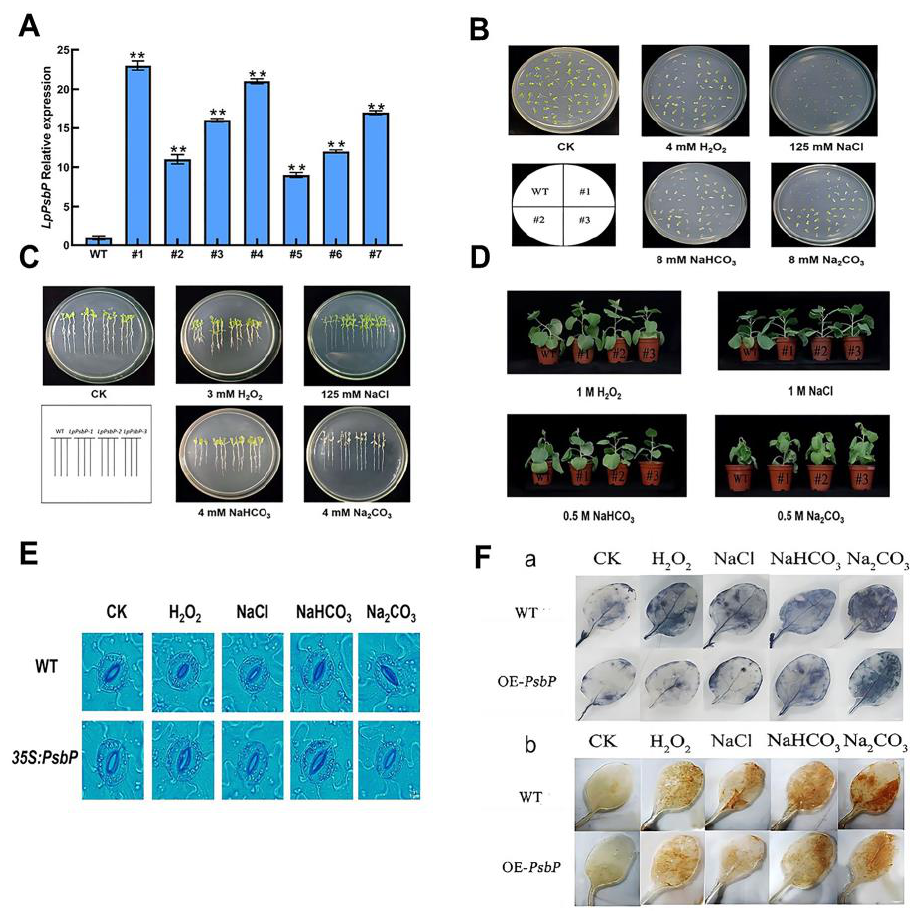
Figure 4. Phenotypic analysis of LpPsbP overexpressed tobaccos. ( A ): qPCR identification of trans- genic tobacco overexpressing LpPsbP gene. cDNA was obtained from the leaves of wild-type and transgenic tobacco plants by reverse-transcribing from RNA. The expression levels were detected by qPCR. WT: wild line; #1-#7: LpPsbP transgenic line; “**” indicates extremely significant difference. ( B ): Germination phenotypic analysis of wild-type tobaccos and LpPsbP transgenic tobaccos under salt stress. Tobacco seeds from the T3 generation, both wild-type and LpPsbP transgenic, were taken and cultured for 7 days in 1/2 MS medium and 1/2 MS media supplemented with 4 mM H 2 O 2 , 125 mM NaCl, 8 mM NaHCO 3 and 8 mM Na 2 CO 3 , respectively. ( C ): Seeding growth of LpPsbP transgenic plants under salt stress. Wild-type tobacco seeds and T3 generation LpPsbP transgenic plants were sown separately in control group and groups in 1/2 MS medium supplemented with 3 mM H 2 O 2 , 125 mM NaCl, 4 mM NaHCO 3 and 4 mM Na 2 CO 3 . The results were recorded after 14 days. ( D ): Phenotypic analysis of LpPsbP transgenic plants under salt stress. Plants were irrigated with 20 mL of 1 M H 2 O 2 , 1 M NaCl, 0.5 M NaHCO 3 and 0.5 M Na 2 CO 3 solutions for 7 days. ( E ): Stomatal size